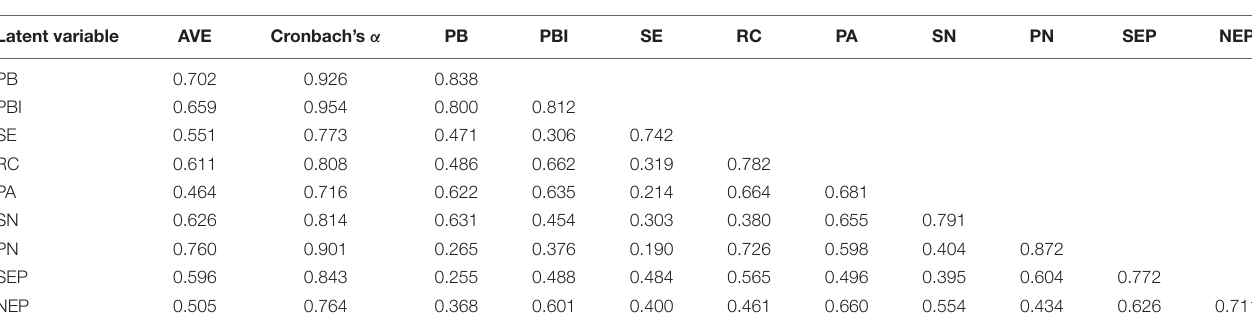
TABLE 5 | Villager participation model differential validity